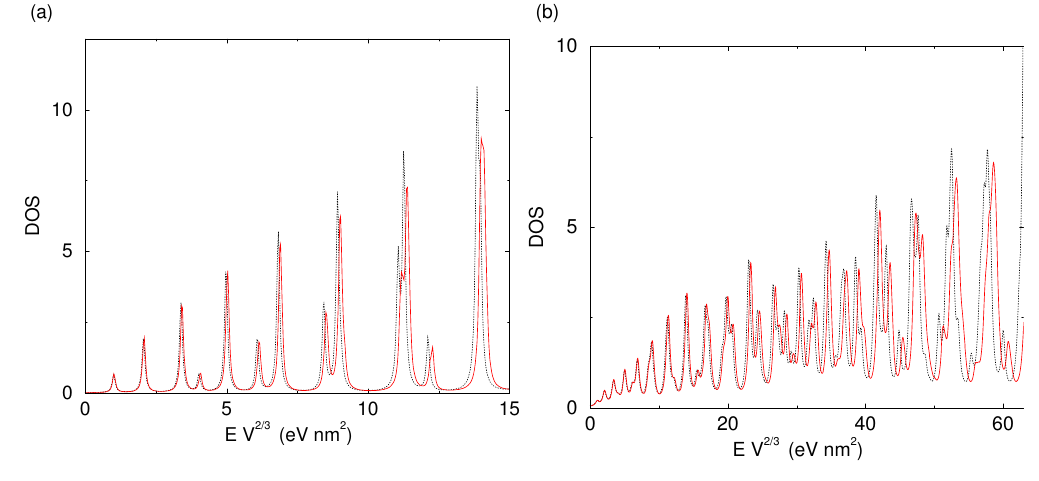
Figure 2. Comparison of the ρ V ( E ) of an electron in a spherical nanoparticle of volume V = 481.42 nm 3 using the calculated (red line) and the analytical eigenenergies (black dotted line). Density of States (DOS) has been calculated using Lorentzian broadening of 1 meV in ( a ); and 5 meV in ( b